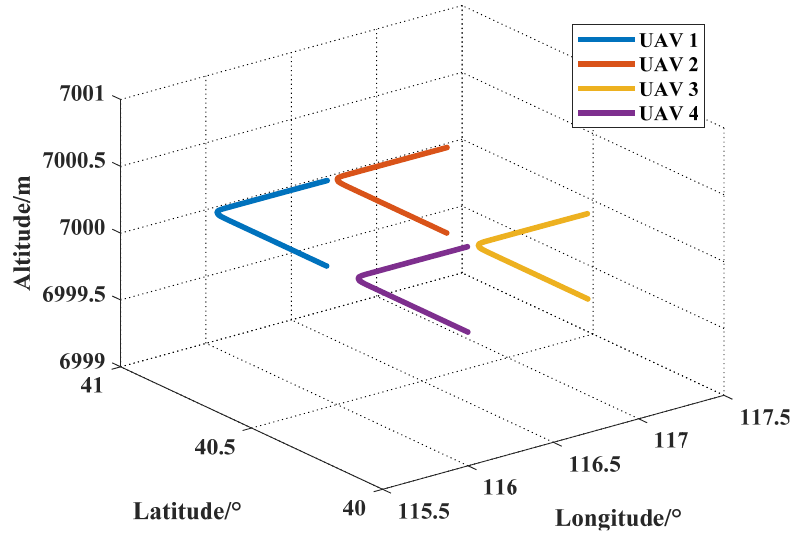
Figure 2. True trajectory of the UAVs. The velocity of the four UAVs in the east–north–up navigation reference frame is shown in Figure 3. (the change at about 220 s was caused by the movement of the UAV).